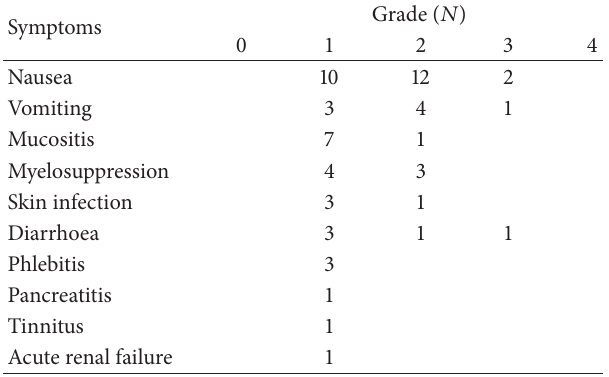
Table 3: Grading of chemotherapy-related side